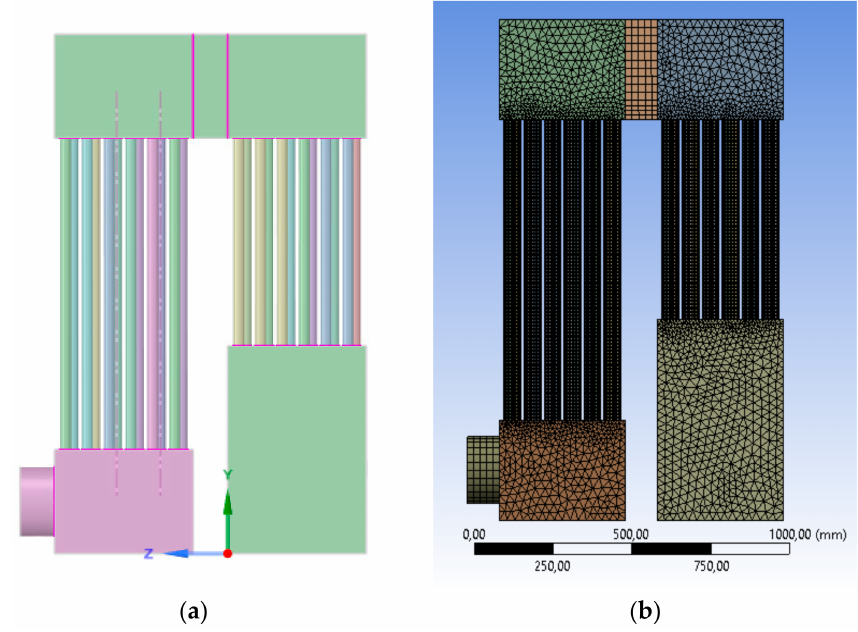
Figure 9. Designed ( a ) and meshed ( b ) model in Ansys